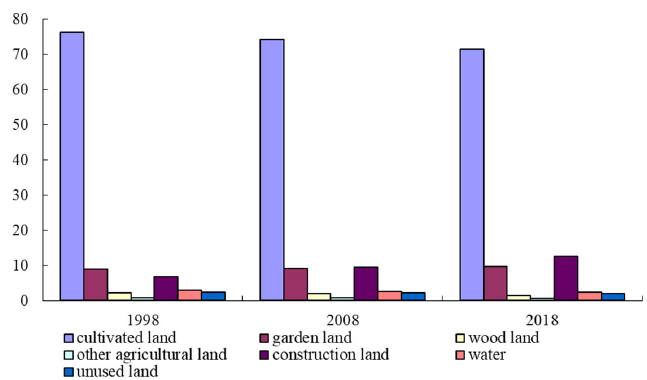
Figure 3. The proportion of land use type distribution from 1998 to 2018.